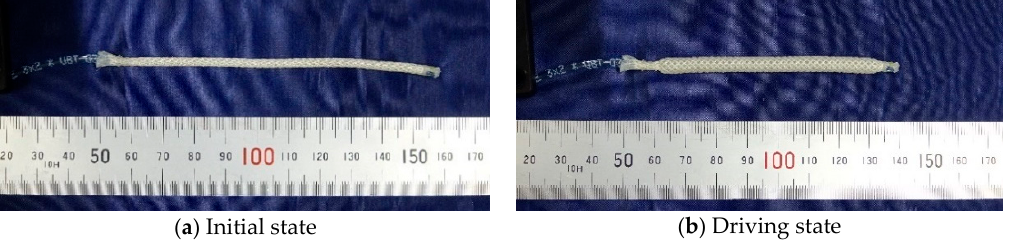
Figure 2. ( a ) Initial and ( b ) driving states of the thin artificial muscle.